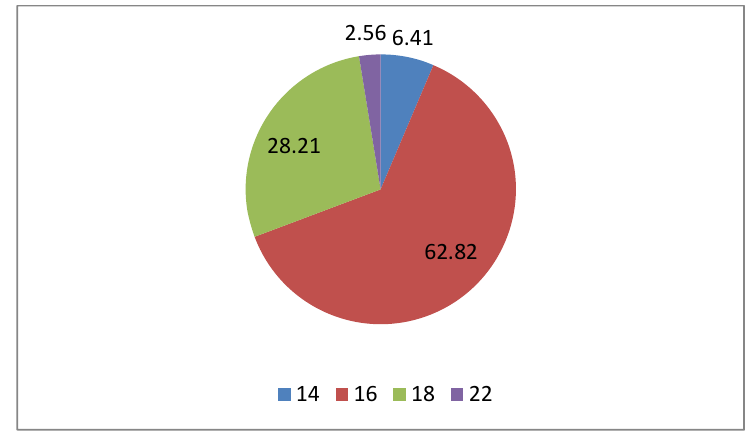
Fig. 1. Years of educational